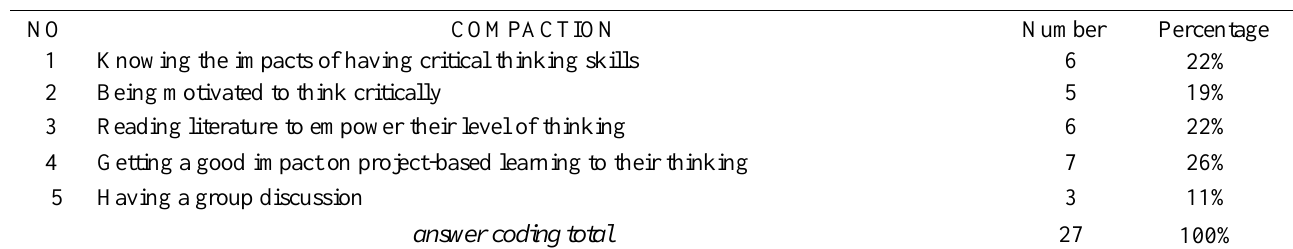
TABLE 1 | 5 Points of Students’ perspective on